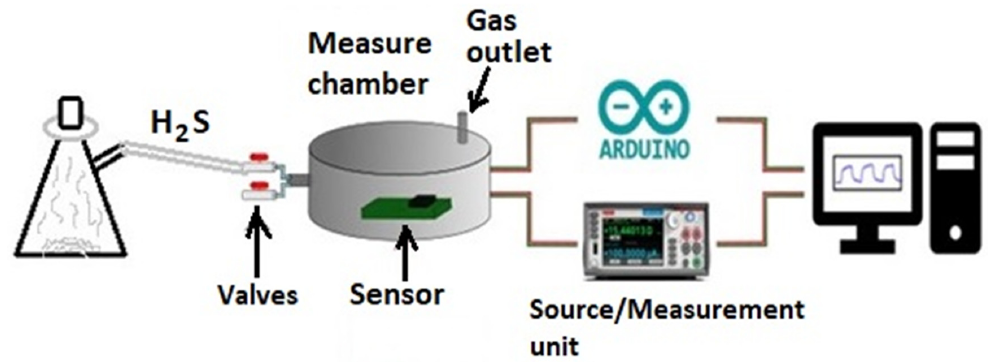
Figure 2. Sensor testing system.